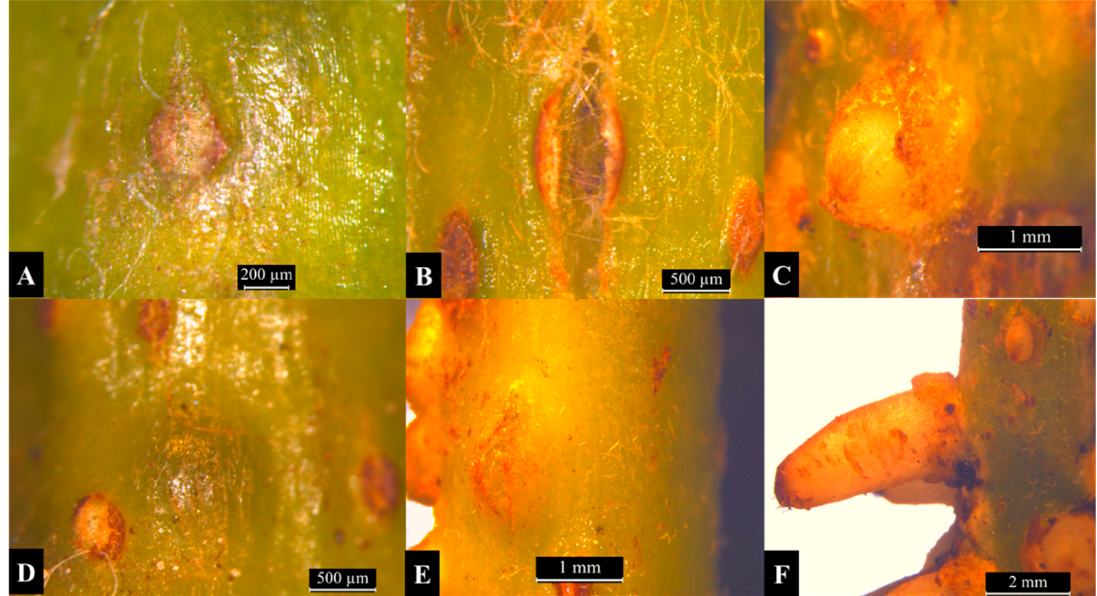
Figure 2. Microscopic morphological changes in the formation of the AR of E. ulmoides cuttings. ( A – C ) adventitious roots were extended from lenticels. ( D – F ) adventitious roots were extended from cortex.